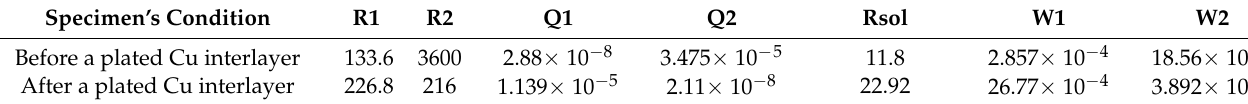
Figure 4. Impedance spectroscopy before and after a plated Cu interlayer and its equivalent circuit. ( a ) Impedance spectroscopy, and ( b ) equivalent circuit. Table 3. Electrochemical impedance values before and after a plated Cu interlayer.